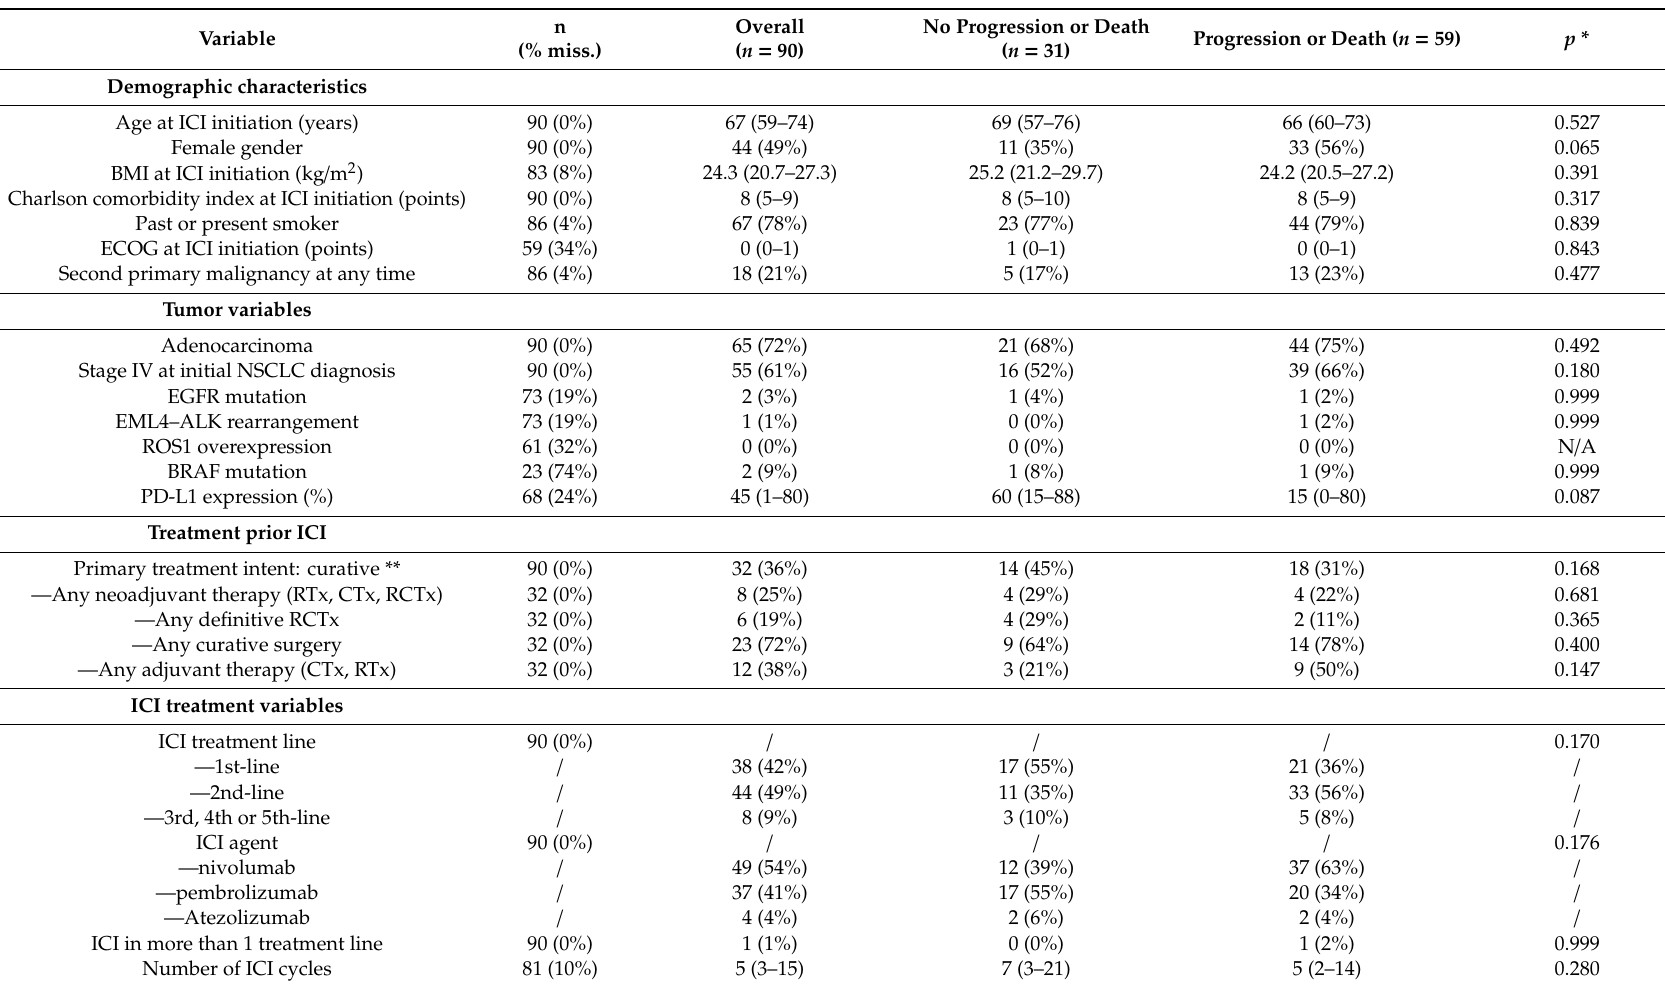
Table 1. Baseline characteristics of the Graz cohort—distribution overall and by progression-free survival (PFS) event